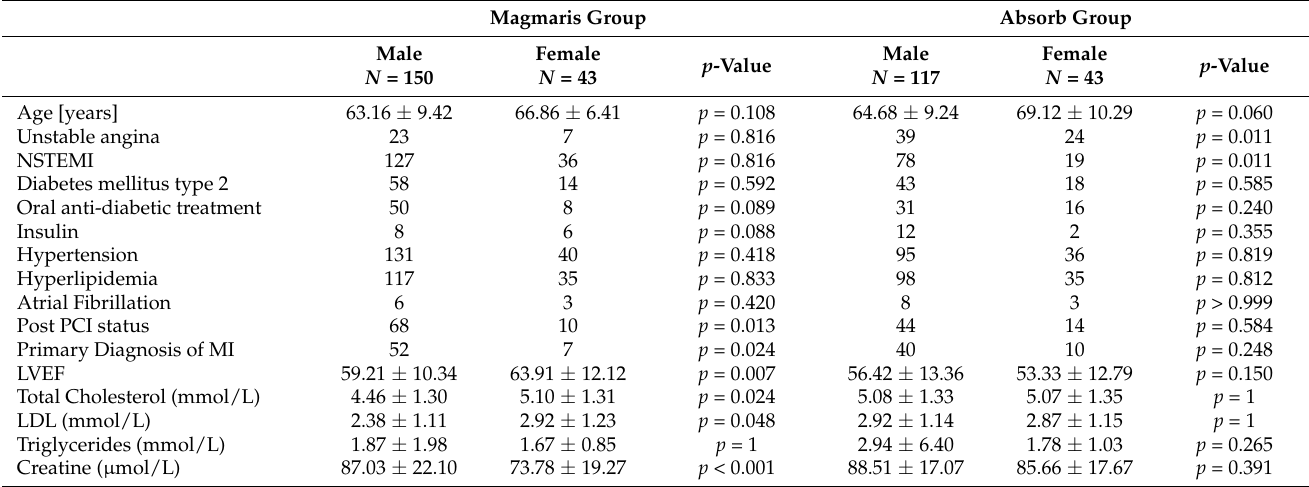
Table 1. Baseline clinical characteristic of both study